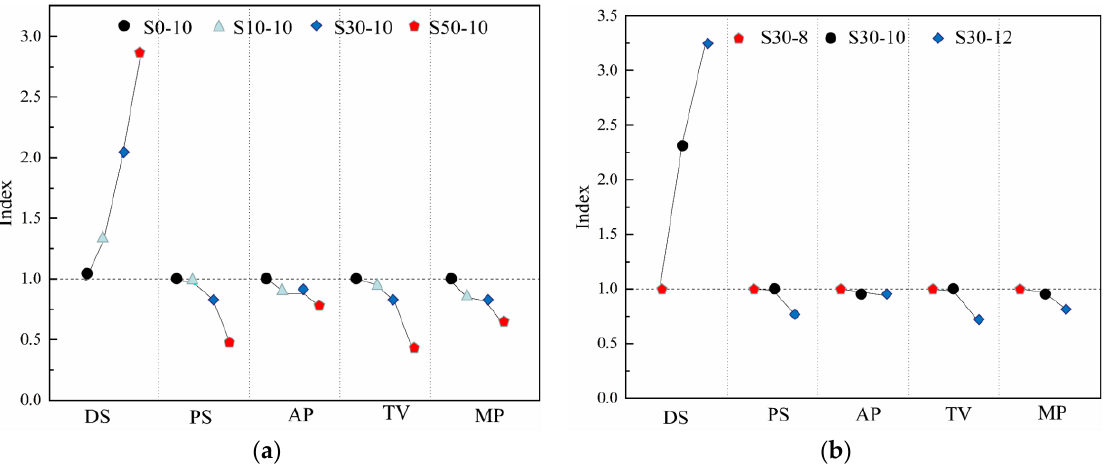
Figure 10. Drying shrinkage and pore structure parameters of the alkali-activated metakaolin-based geopolymers according to the ( a ) slag and ( b ) Na 2 O content.